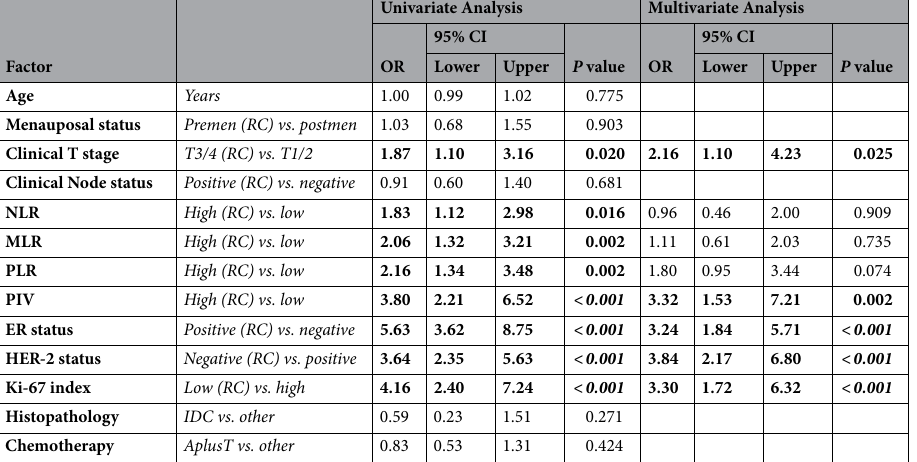
Table 4. Univariate and multivariate logistic regression analysis for the predictors of pathological complete response. OR odds ratio, CI confidential interval, RC reference category, NLR neutrophil-to-lymphocyte ratio, MLR monocyte-to-lymphocyte ratio, PLR platelet-to-lymphocyte ratio, PIV Pan-immune-inflammation-value, ER estrogen receptor, HER-2 human epidermal growth factor receptor-2, IDC invasive ductal carcinoma, AplusT anthracycline plus taxane. The multivariate logistic regression model is significant ( p < 0.001). Bold numbers indicate statistical significance.